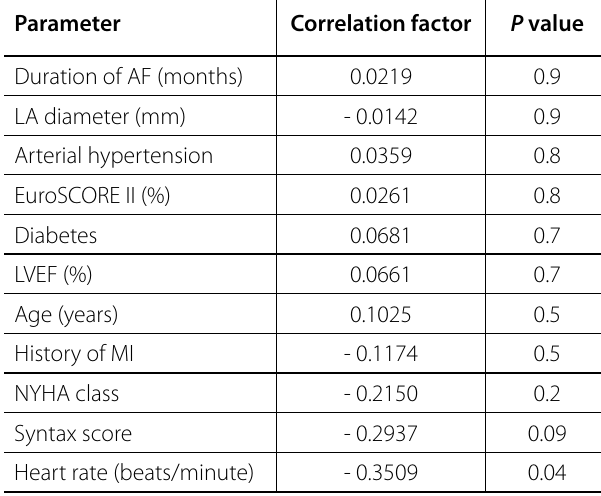
Table 3 . Correlation between the number of GP detected and preoperative variables.